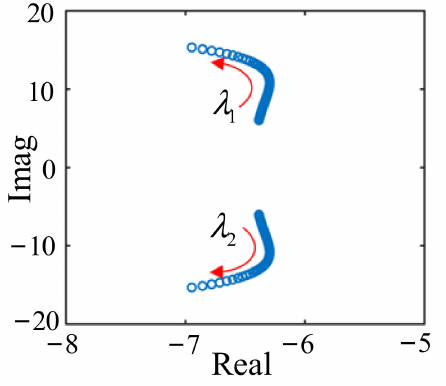
Figure 8. Eigenvalue trajectories under different resistance inductance ratios of connecting lines.